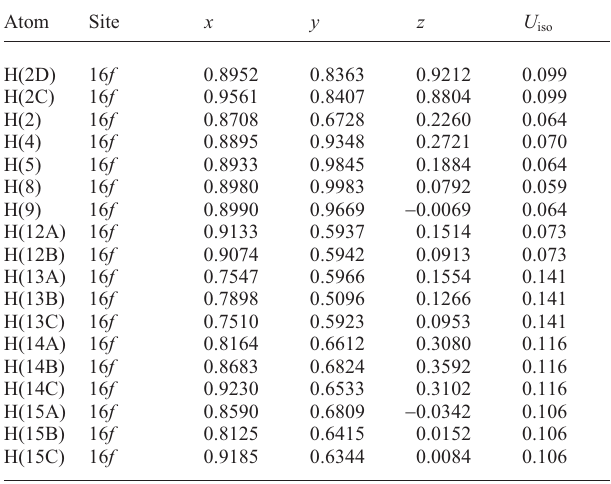
Table 2. Atomic coordinates and displacement parameters (in Å 2 )